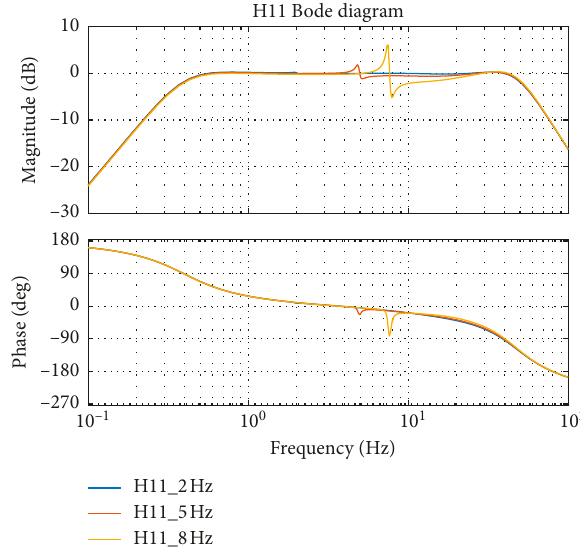
Figure 4: Effect of specimen’s mass on frequency response of H